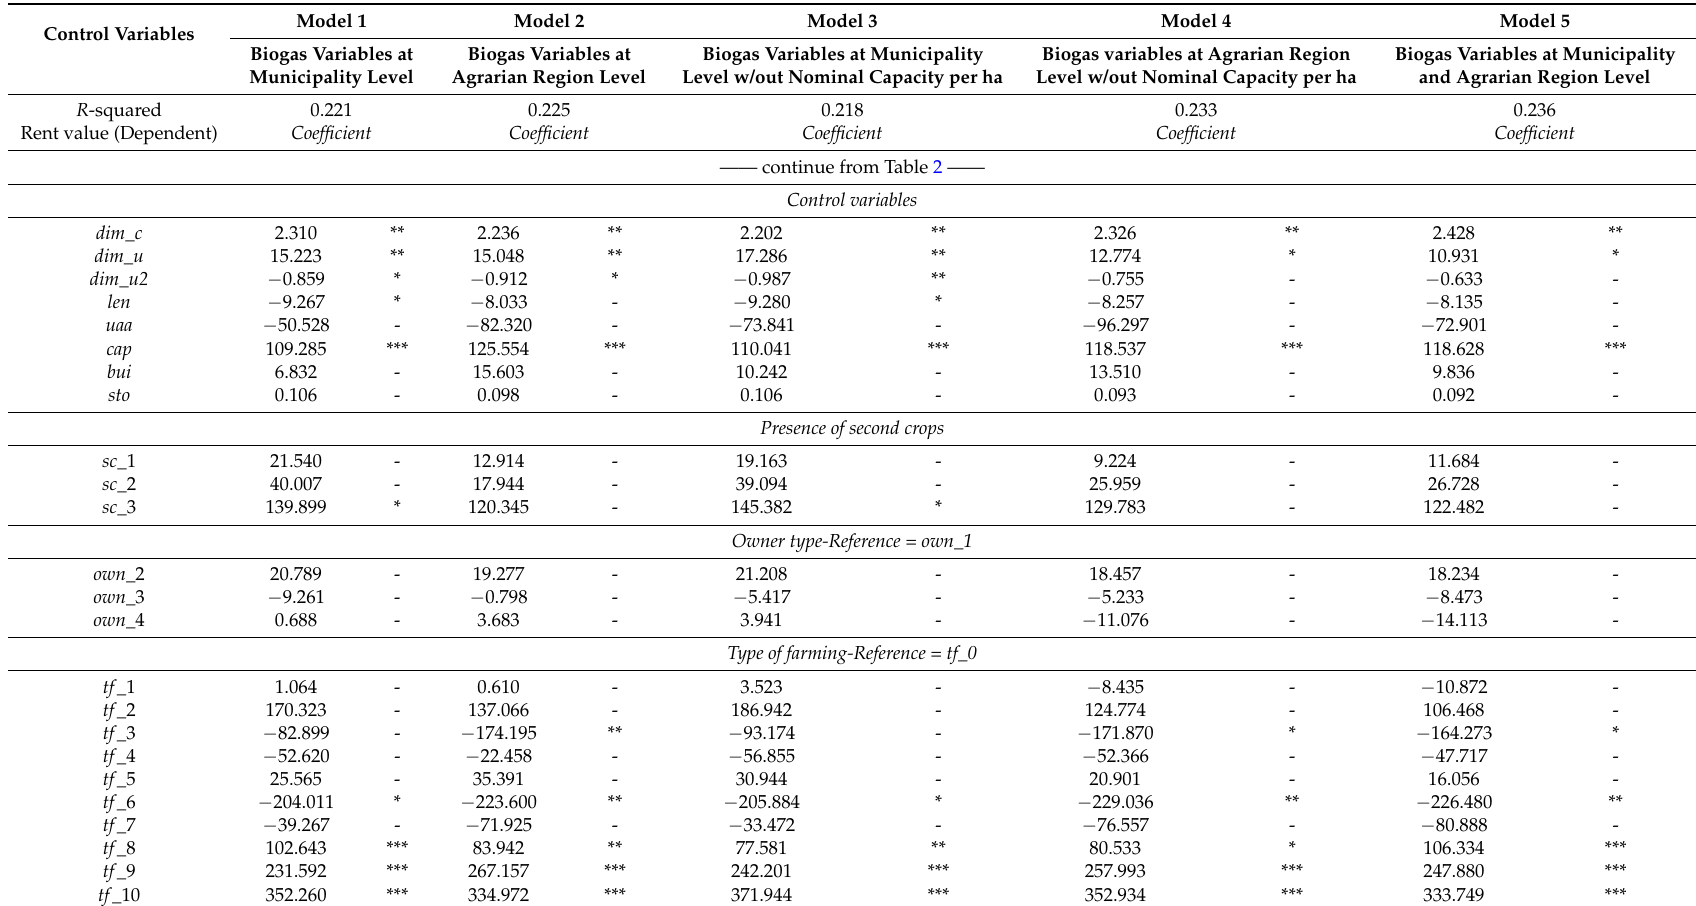
Table D1. Estimation results for control variables in Table